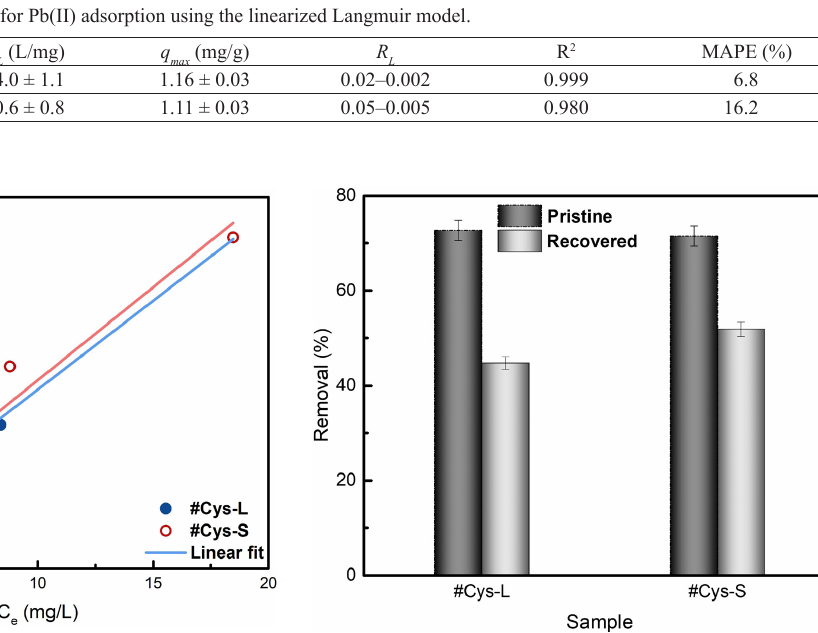
Figure 9. Adsorption data at pH 5 fitted with the linearized form of the Langmuir model.